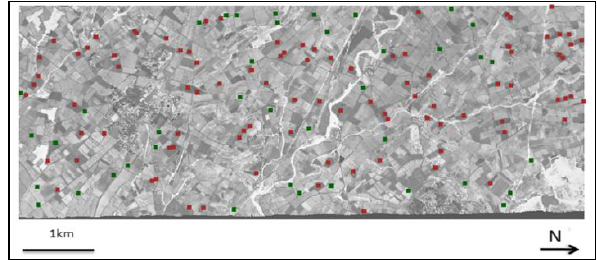
Figure 1: HyMap hyperspectral image (in red the 95 soil samples, in green the 40 soil samples).